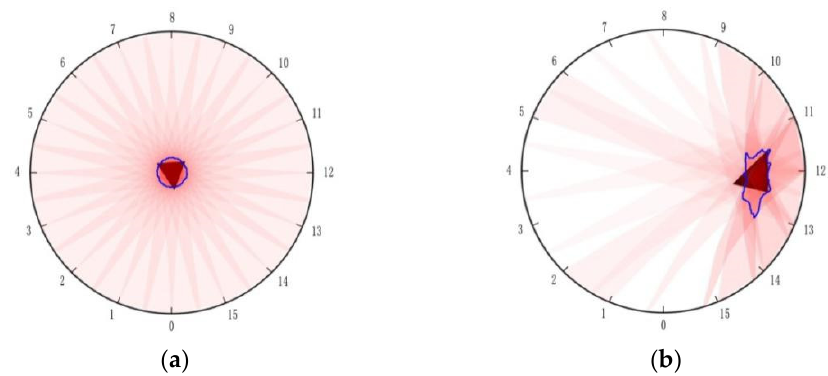
Figure 11. ( a ) The object lying in the central region; ( b ) The object lying in the fringe region.